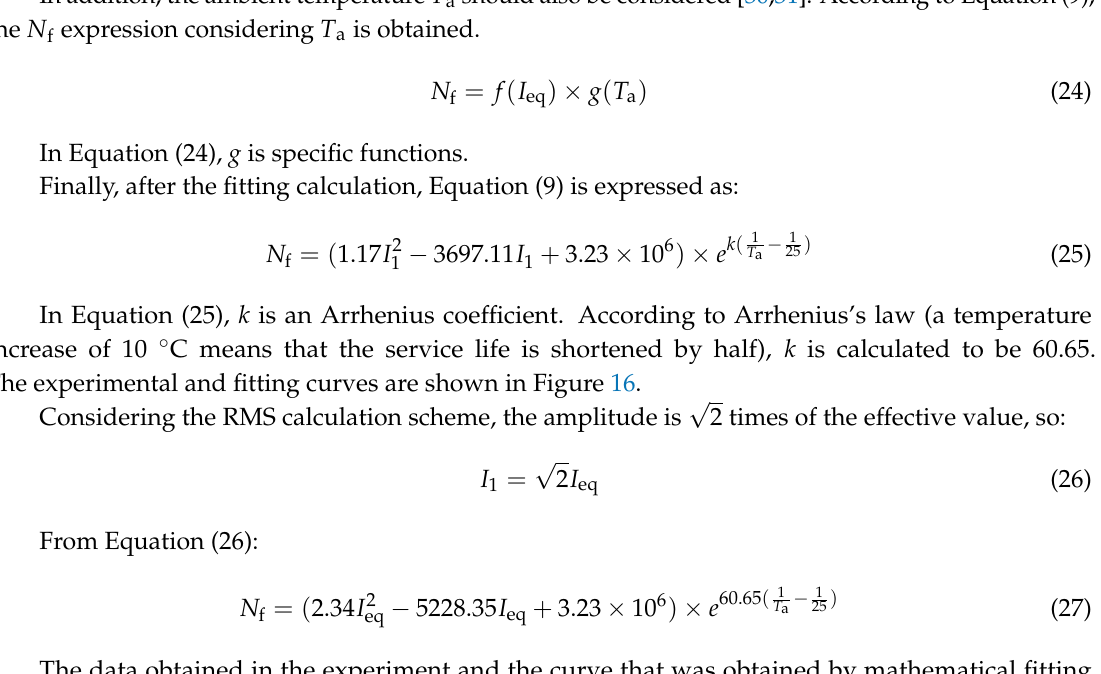
Figure 15. Curves obtained under different BAFT aging currents.